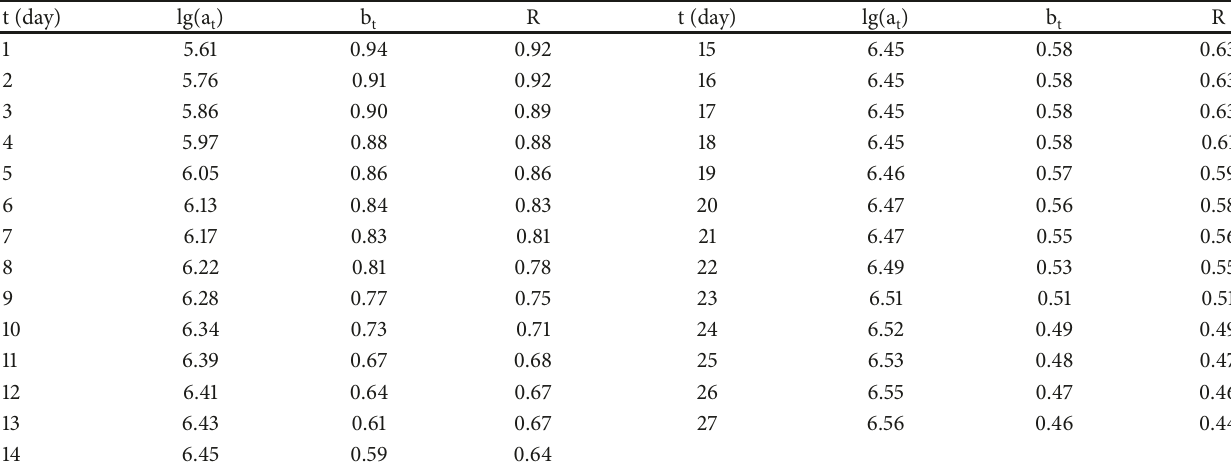
Table 1: The coefficients (a t and b t ) and the correlation coefficient (R) of the fitting linear equation in Figure 5.